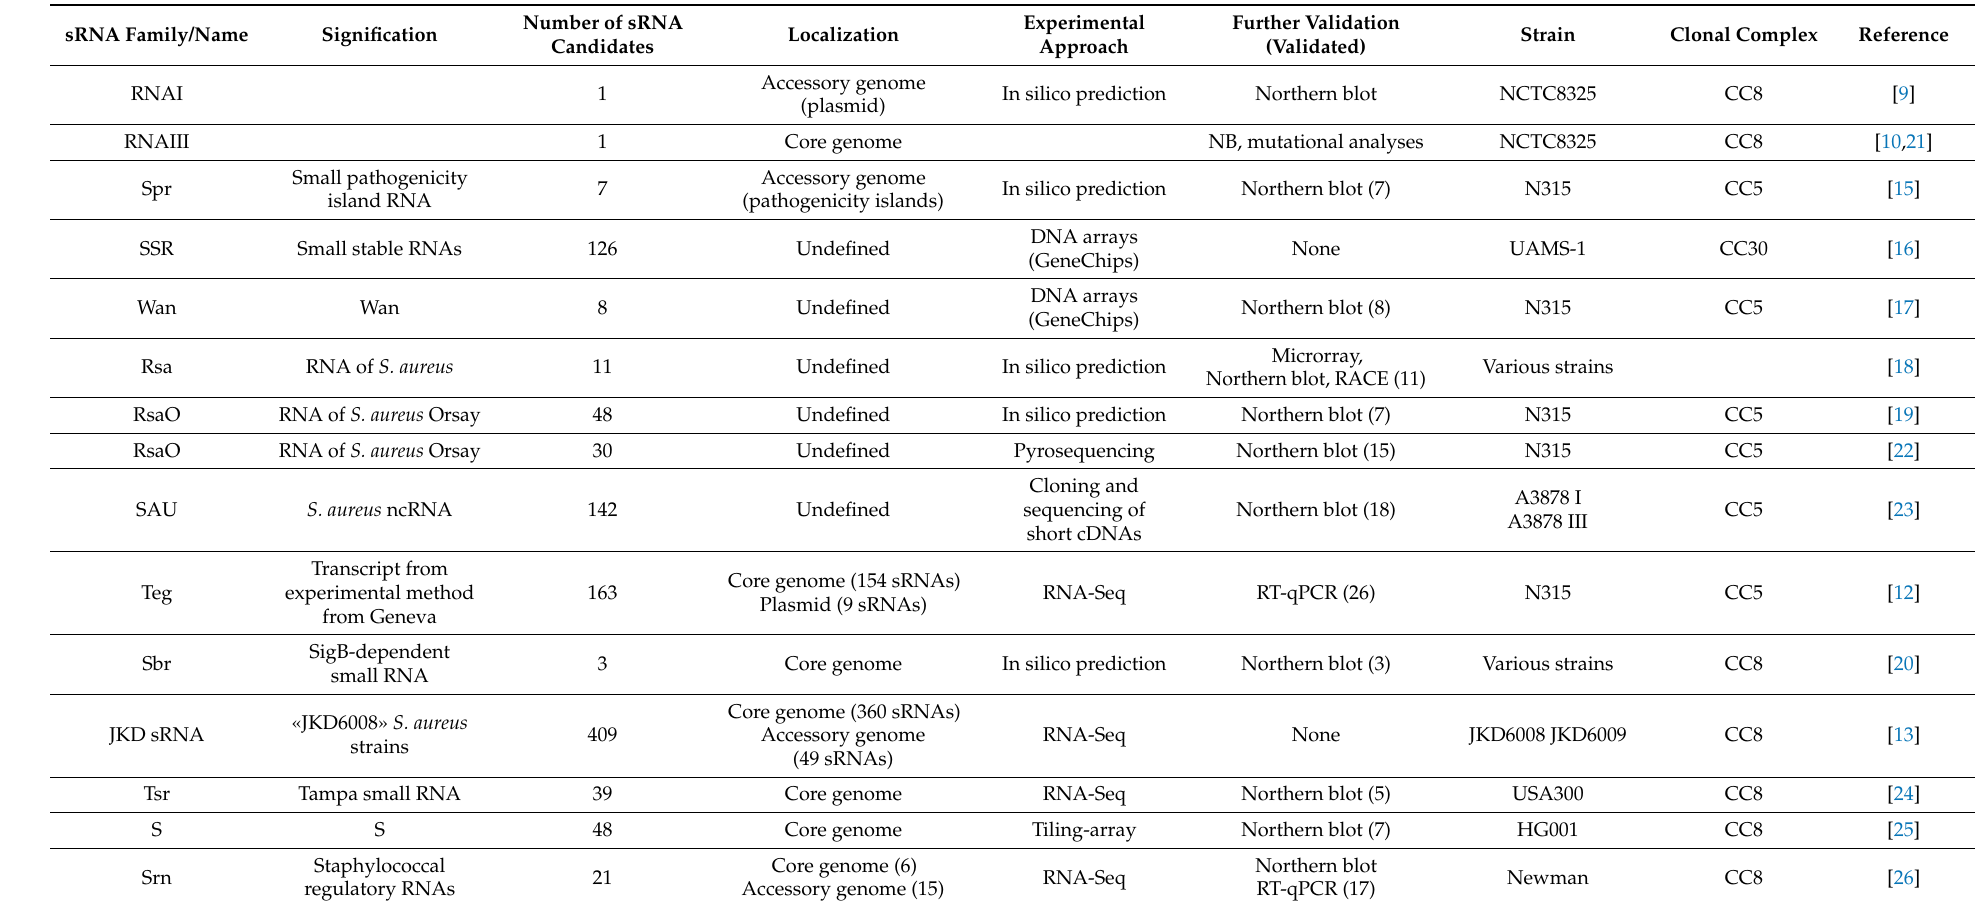
Table 1. Classification and cartography of major Staphylococcus aureus sRNA